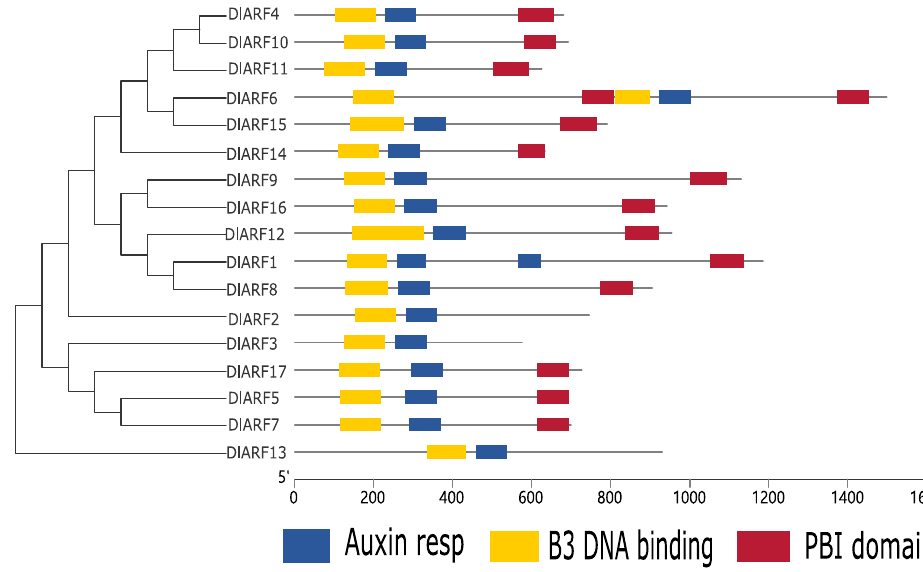
Figure 4. Analysis of conserved domain in DlARFs proteins. All conserved domains were identified by MEME database with the complete amino acid sequences of DlARF s .